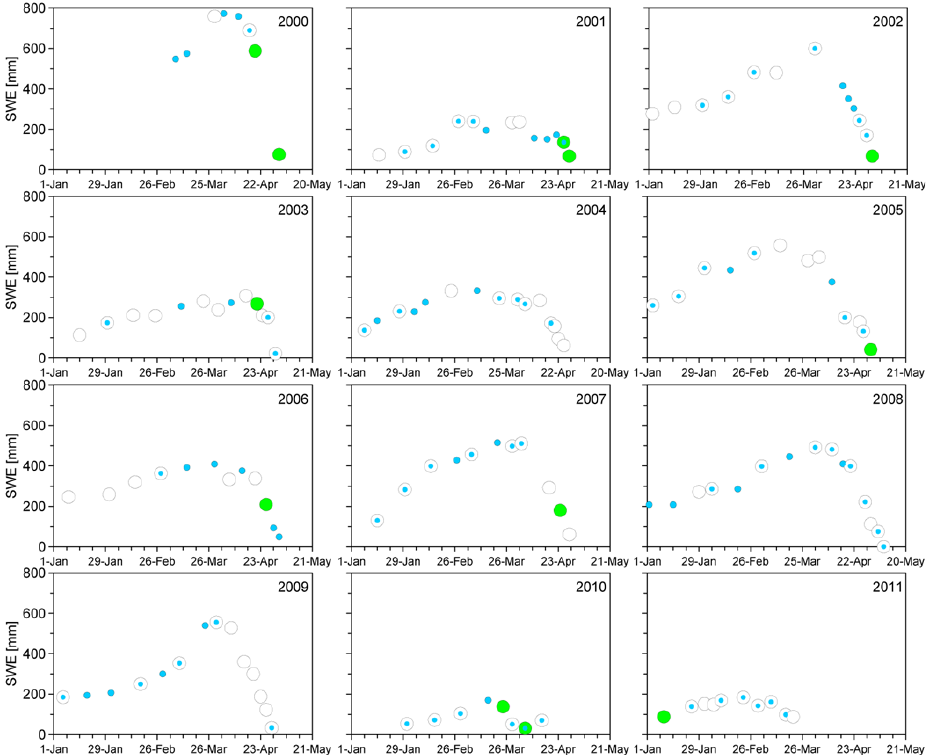
Fig. 8. Snow water equivalent (SWE) observations at ˇCervenec station and MODIS classification at the respective pixel in individual snow seasons (2000–2011). Colors indicate MODIS snow (white), land (green) and cloud (blue) classifications. Overlapping of smaller (cloud) with larger (snow or land) symbols indicates the information is from the MODIS 2-day filter instead of the original cloud classification by MODIS for that day.